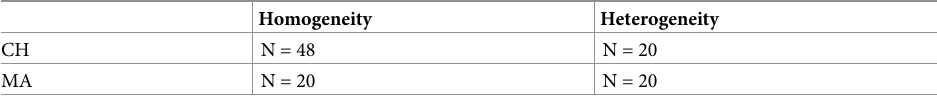
Table 1. Treatments and sample sizes in the 2 x 2 design of the CPR experiment. On one dimension, village (CH: Chwaka, MA: Marumbi) is varied by recruiting subjects from two different locations, on the other dimension, sociocul- tural group heterogeneity is varied by placing subjects either in homogeneous (single-village) or heterogeneous (mixed-village) groups. Homogeneity Heterogeneity CH N = 48 N = 20 N =